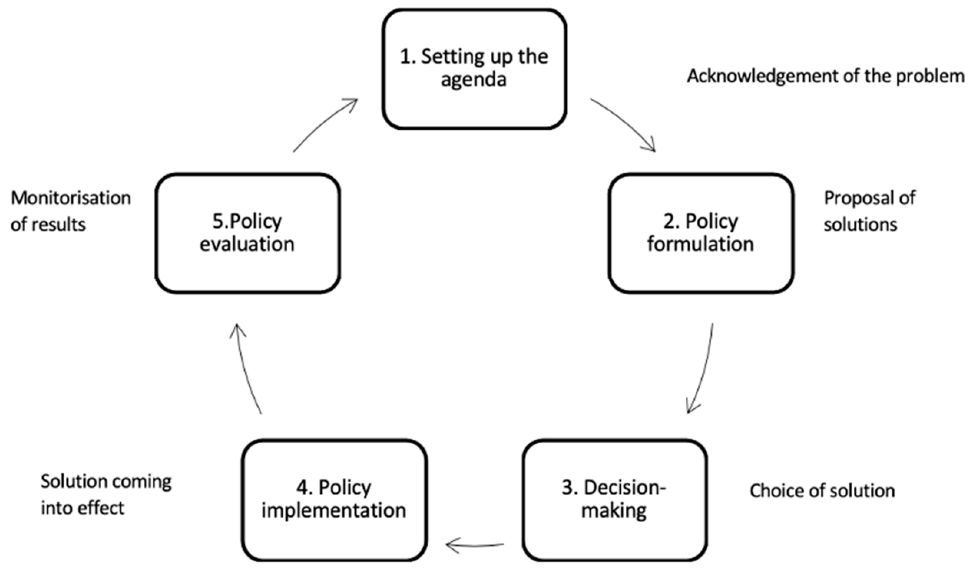
Figure 1. Public policy cycle (Lasswell, 1957).